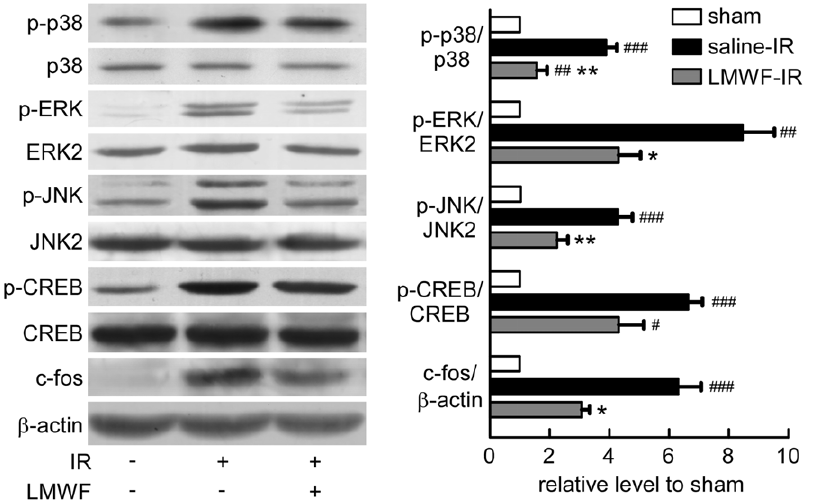
Figure 4. LMWF inhibited MAPK signaling pathway in kidney after IR. Expression levels of ERK, p38, JNK, CREB and c-fos of kidneys after reperfusion for 2 h were detected by Western blot analysis. Representative blotting ( left ) and quantification of protein levels ( right ) are shown. Mean 6 SEM. n=3; # P , 0.05, ## P , 0.01, ### P , 0.001 vs. sham, * P , 0.05, ** P , 0.01 vs. saline treated IR group.